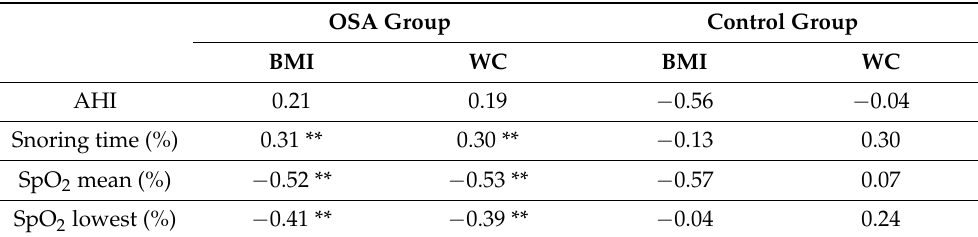
Table 3. Correlation between parameters of sleep disorders and anthropometric measurements in patients with and without obstructive sleep